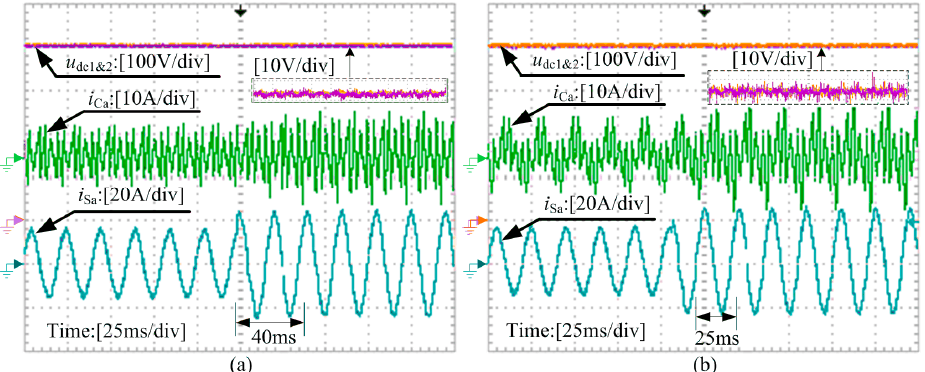
Figure 15. Dynamic response of NPC-SAPF. ( a ) λ = − 1 × 10 − 2 ; and ( b ) λ = − 1 × 10 − 3 .